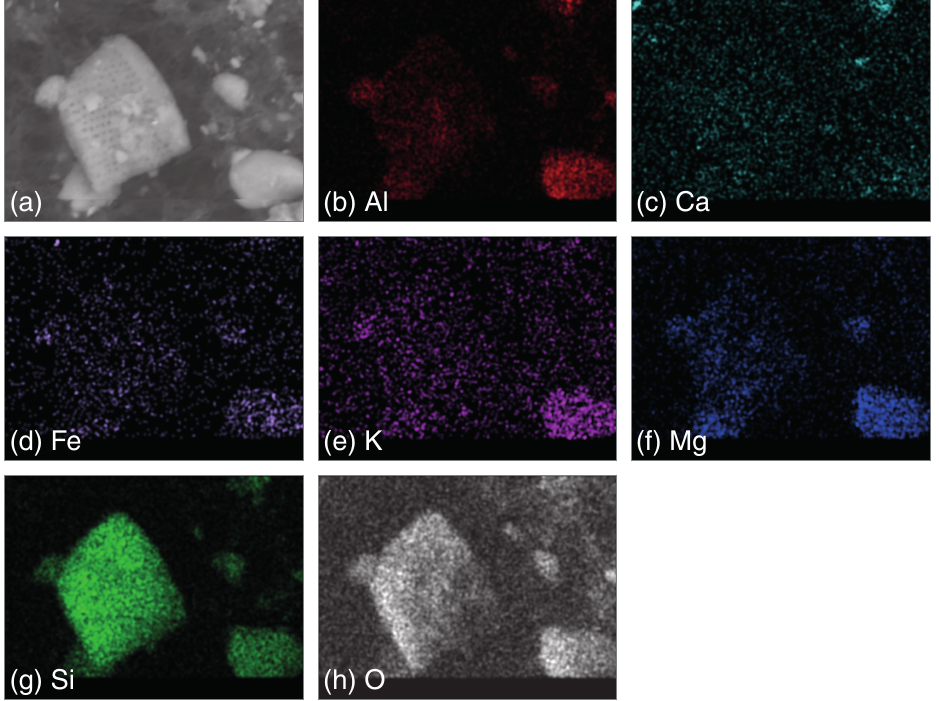
Figure 11. SEM/EDX map of biological marker (i.e., species Aulacoseira ) found in dust sample. ( a ) SEM image, ( b – h ) elemental composition derived from EDX for Al, Ca, Fe, K, Mg, Si,